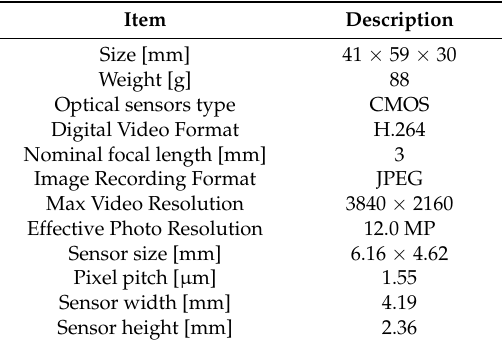
Table 1. Technical specification of GoPro 4 Hero Black camera.